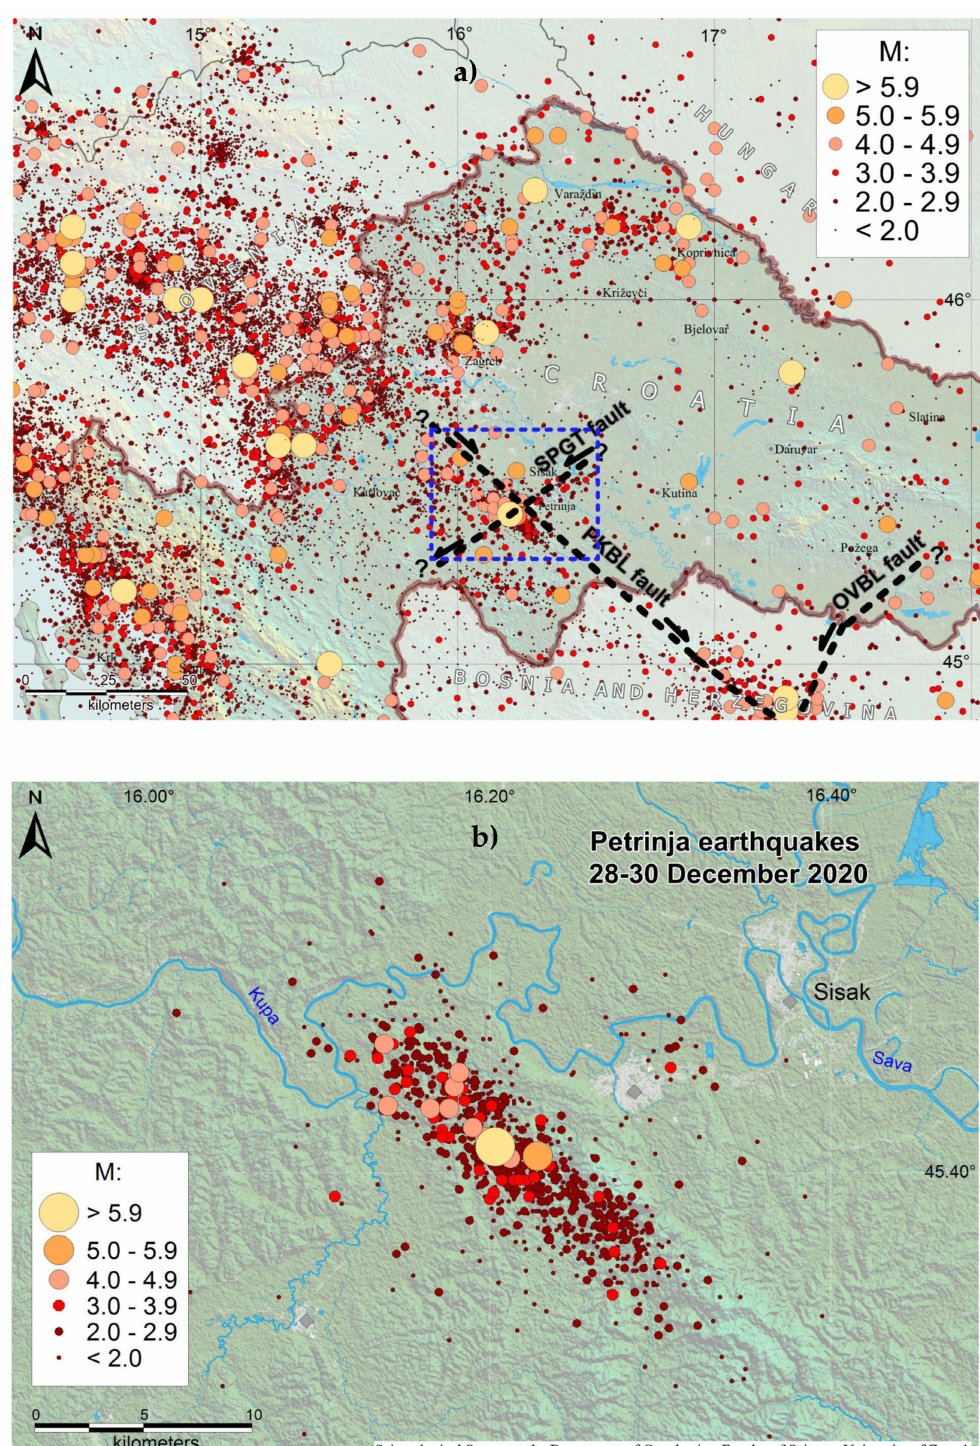
Figure 1. ( a ) The spatial distribution of earthquakes in Croatia (373 BC–2019, according to the Croatian Earthquake Catalogue (CEC), of which an updated version was first described in [4], with the Pokupsko-Petrinja epicentral area indicated (blue rectangle). Thick, black-dashed lines mark regional active faults: PKBL=Pokuplje-Kostajnica-Banja Luka right-lateral fault, SPGT=Sisak- Petrinja-Glina-Topusko left-lateral fault and OVBL=Orljava-Vrbas-Banja Luka left-lateral fault; and ( b ) Pokupsko-Petrinja epicentral area with the distribution of the epicentres of the 28 to 30 December 2020 seismic